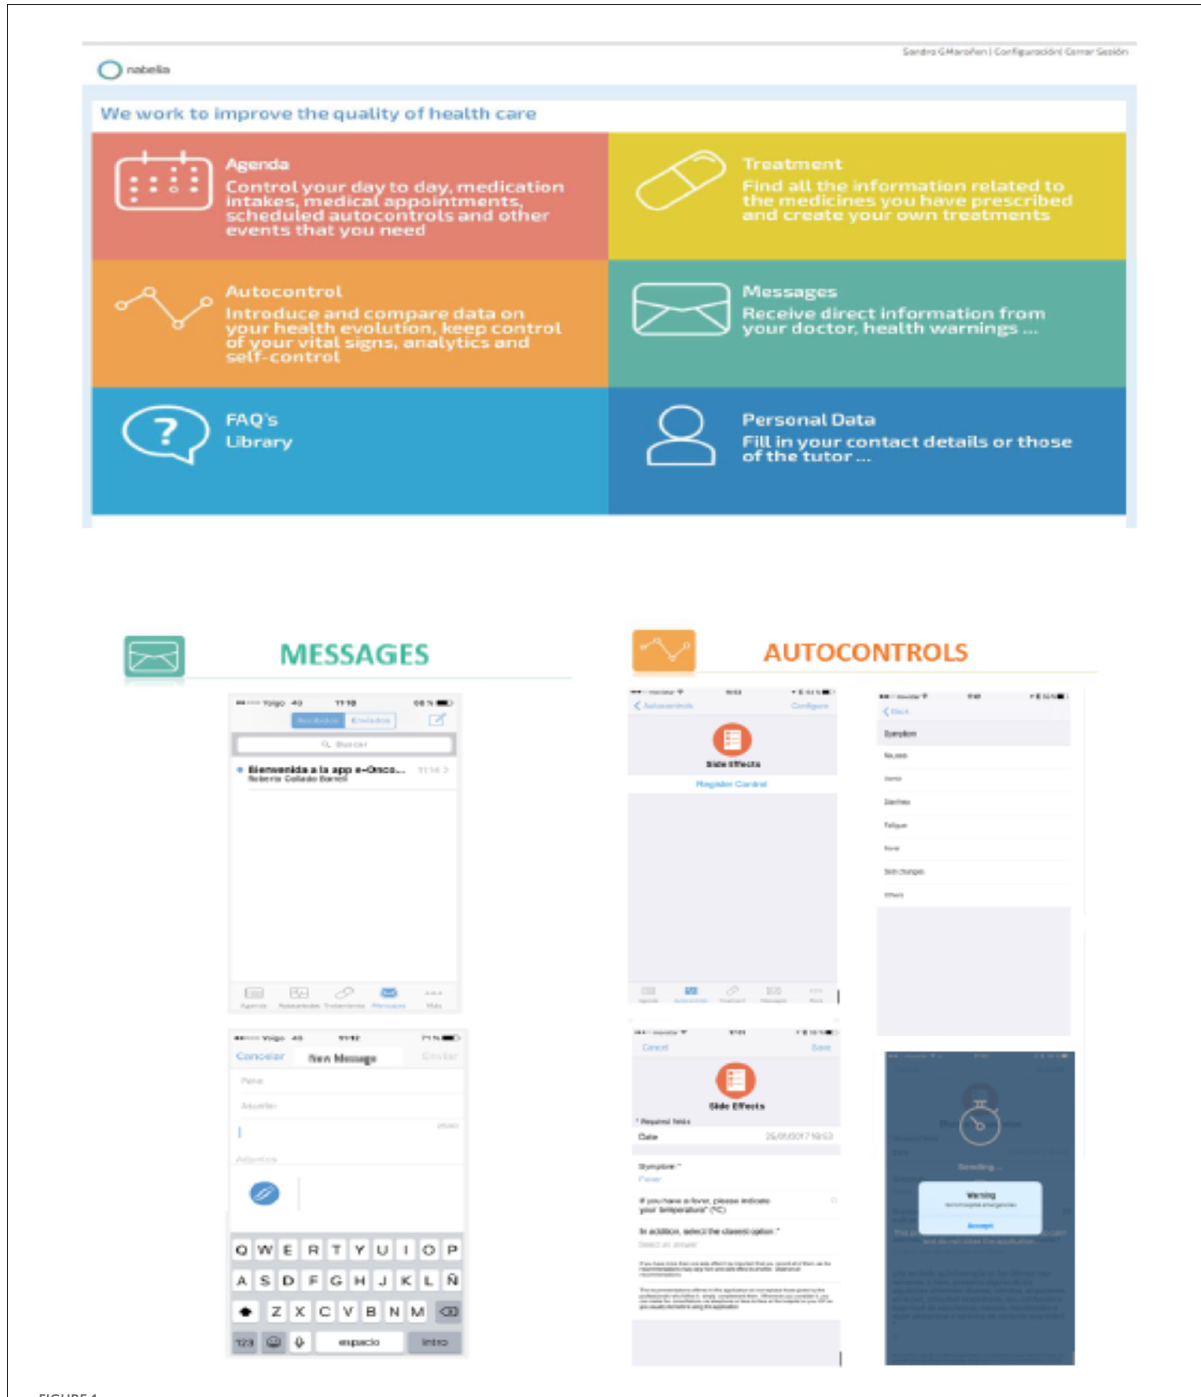
FIGURE1 Functional diagram of the app